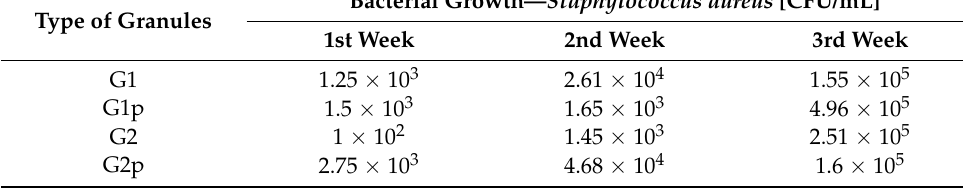
Table 6. Bacterial growth of S. aureus in a medium containing selected examined samples after 24 h of incubation in three repetitions with weekly